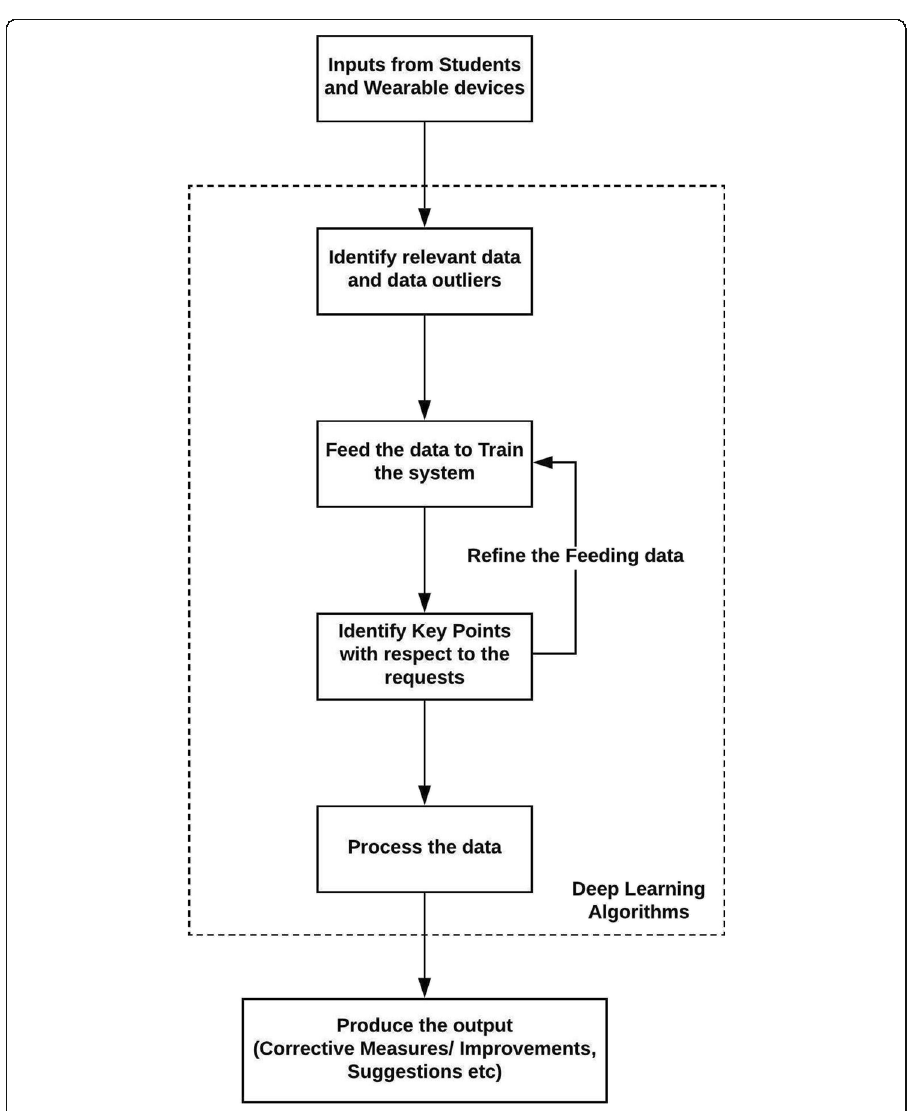
Fig. 6 Proposed Learning Analytics System Model. The various steps and components involved in creating the learning analytics